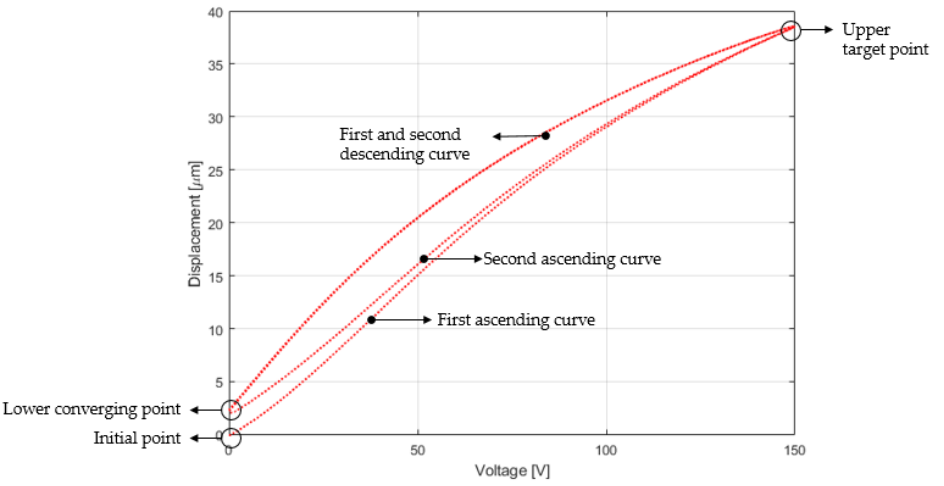
Figure 2. Hysteresis graph description of the commercial Piezoelectric actuator